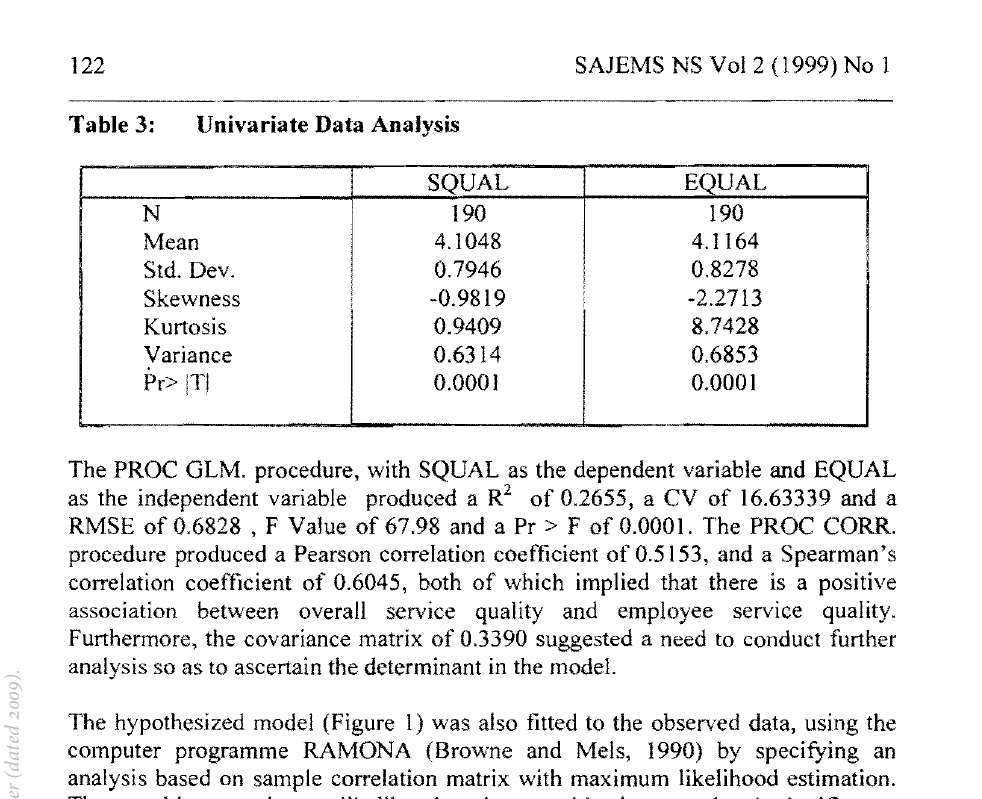
Univariate Data